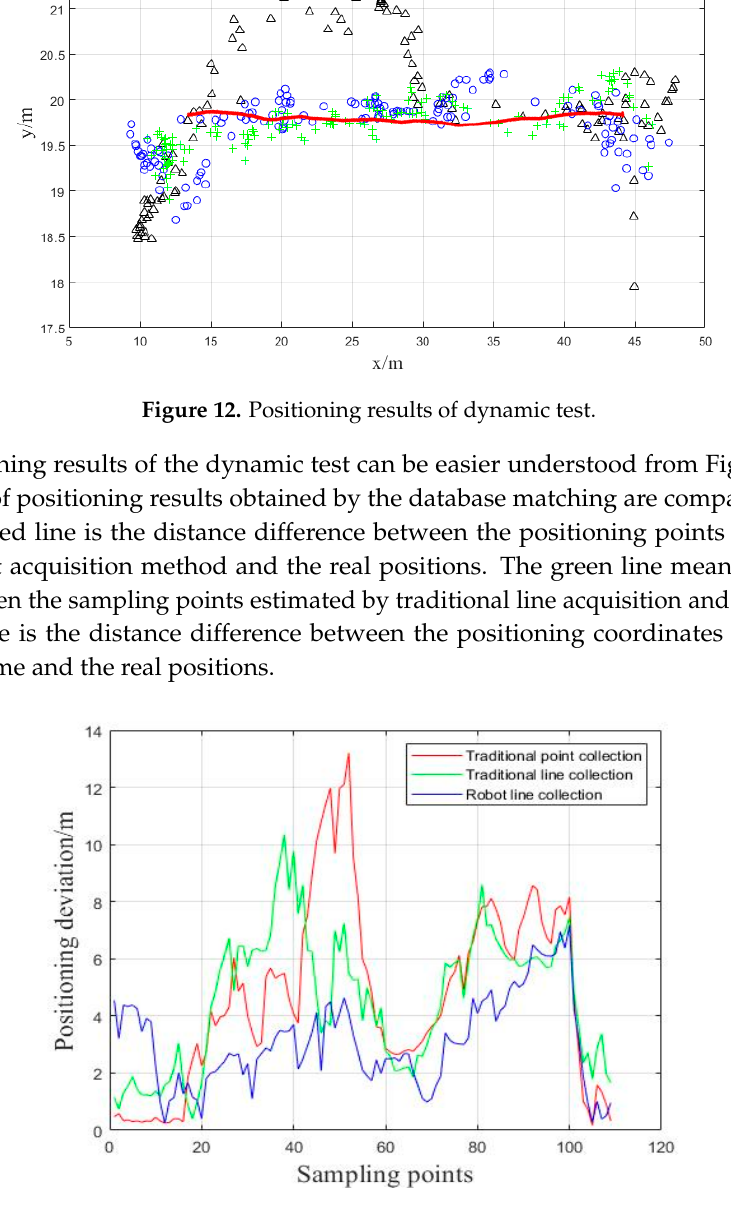
Figure 13. Positioning deviation of dynamic test.